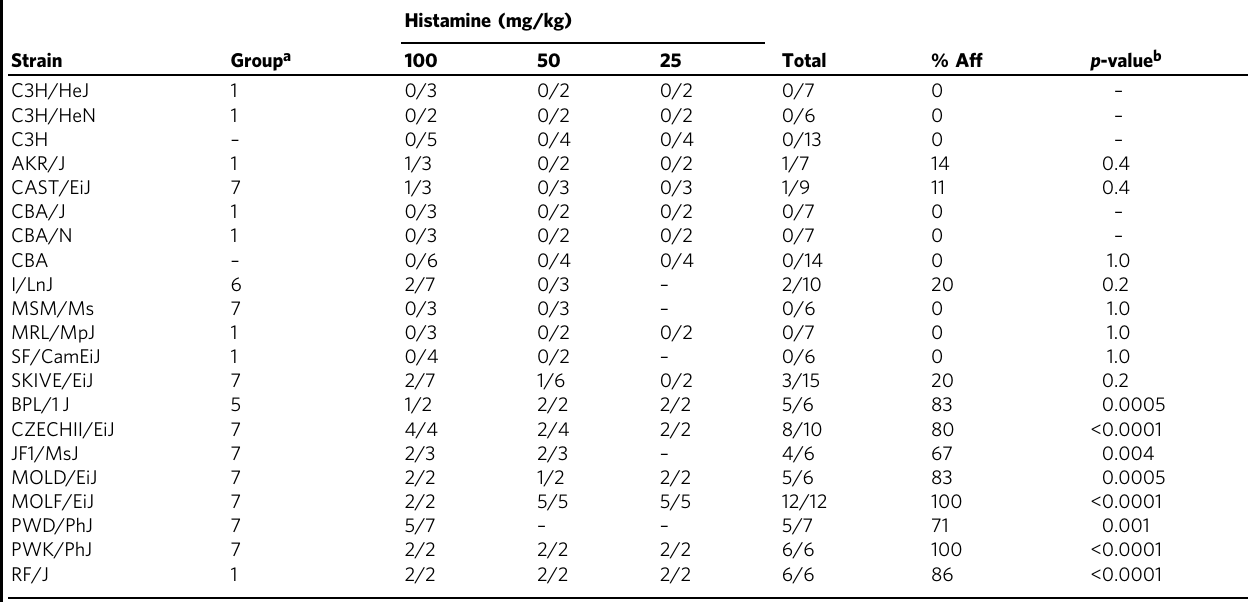
Table 2 Bphs susceptibility of mice with the Hrh1 r